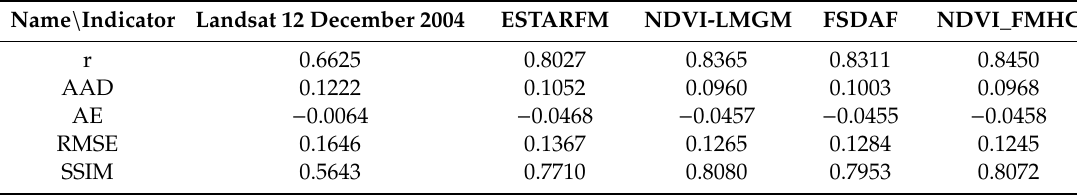
Figure 12. Visual comparison of inset map in the flood area. ( a , b ). Original Landsat_NDVI inset map 26 November and 12 December 2004; ( c – f ). Predicted Landsat_NDVI inset map by ESTARFM, NDVI-LMGM, FSDAF, and NDVI_FMHC. Table 4. Accuracy comparison of four fusion methods in the flood area.